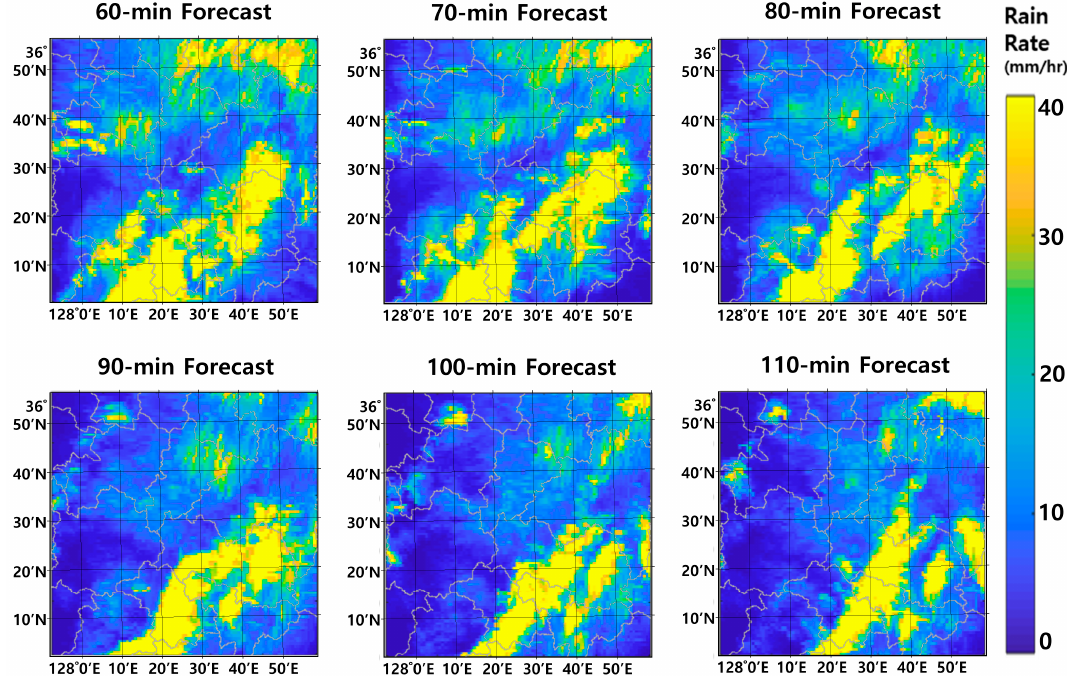
Figure 7. Rainfall forecasts made at 09:00 8 July 2017 for the lead times from 60 min to 110 min.